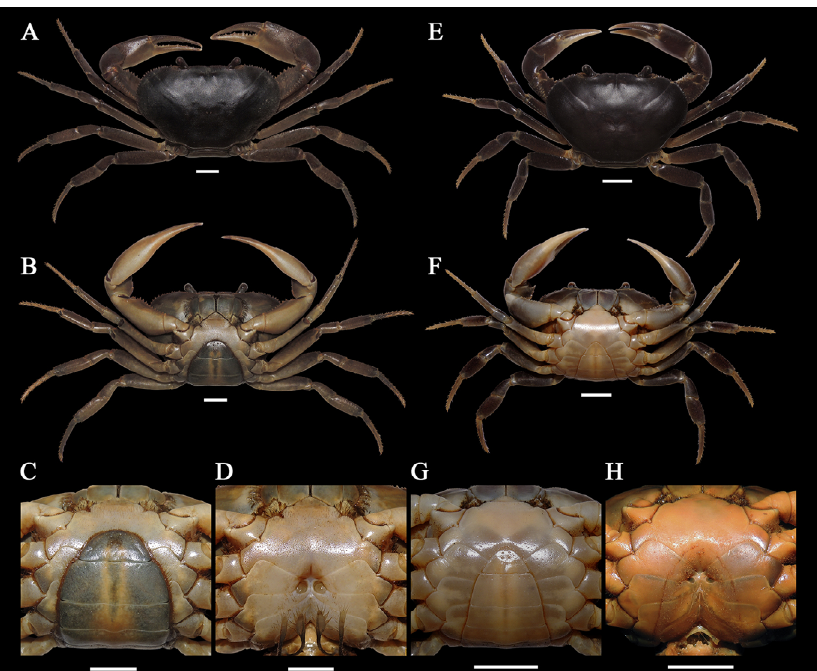
Figure 5. Adult female Epilobocera capolongoi (CZACC 5.0045) ( A – D ) and subadult female E. cubensis (CZACC 5.0059) ( E – H ) from Lomas de Banao Ecological Reserve. A , E , Habitus, dorsal view; B , F , habitus, ventral view; C , D , G , H , sternal surface, with detail of the vulvae ( D , H ). All the images were taken soon after death (keeping the coloration in life), except H (after preservation). Scale bars = 10 mm.